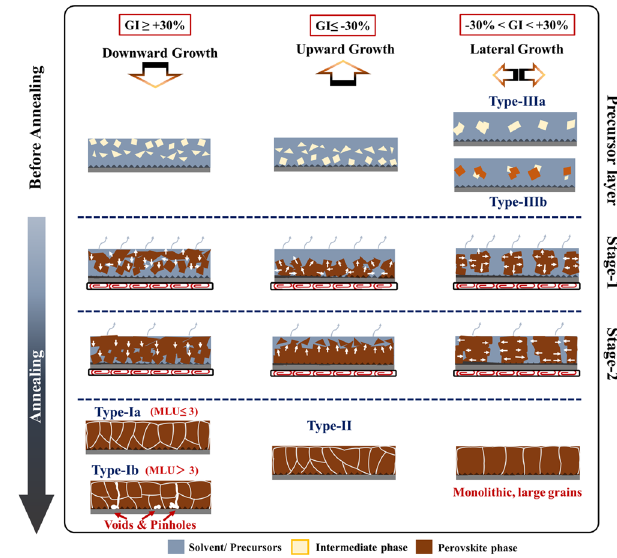
Fig. 6 | Parameters and typologies of perovskite layers growth models. Per- ovskite fi lm formation process upon annealing. Typology of perovskite fi lms growth: Grain growth direction, mechanism, and growth parameters. The white arrows point to the growth directions.